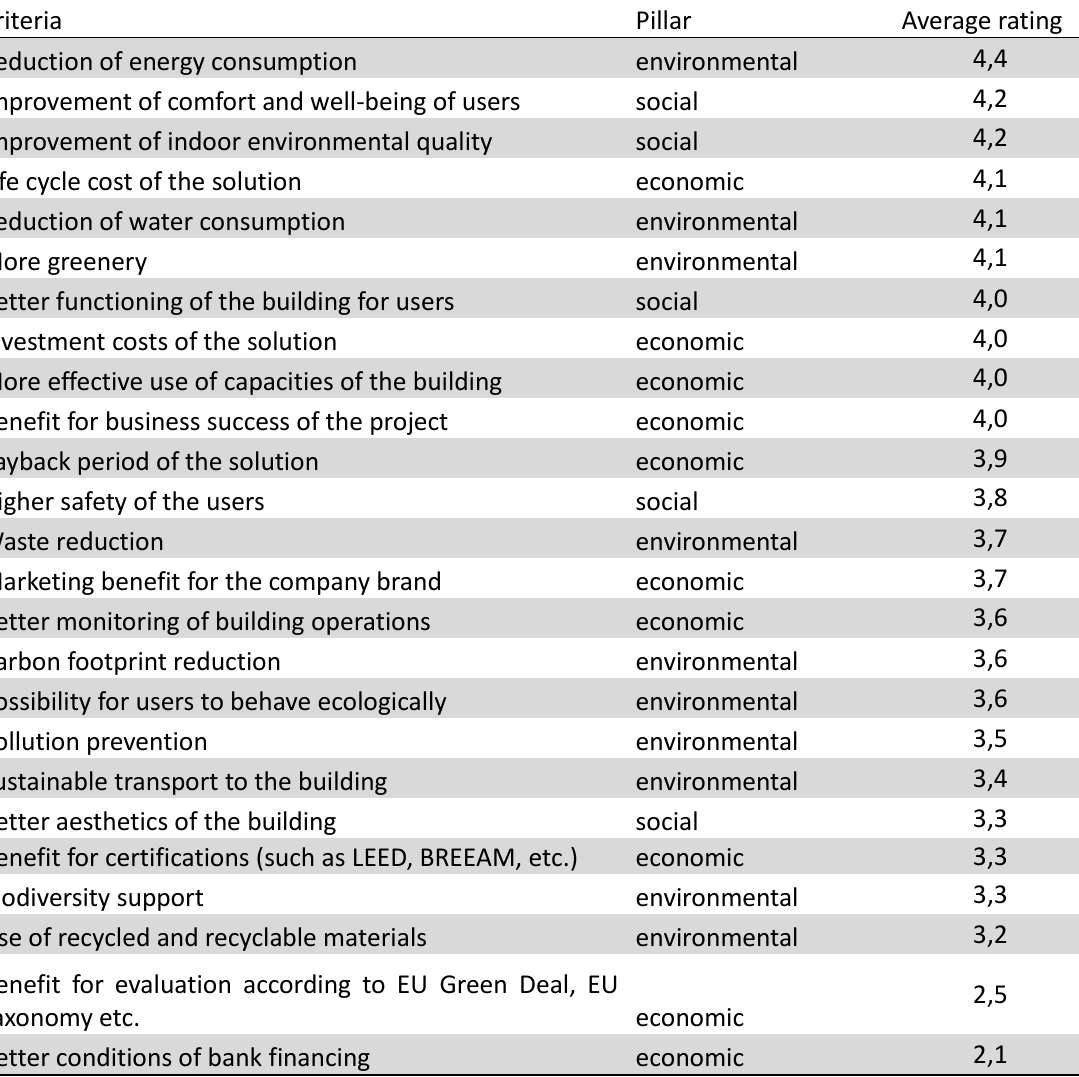
Table 3: Criteria for evaluation of sustainable solutions rated by the respondents from 0 to 5 as the most important, order from the highest average rating (source: authors) Criteria